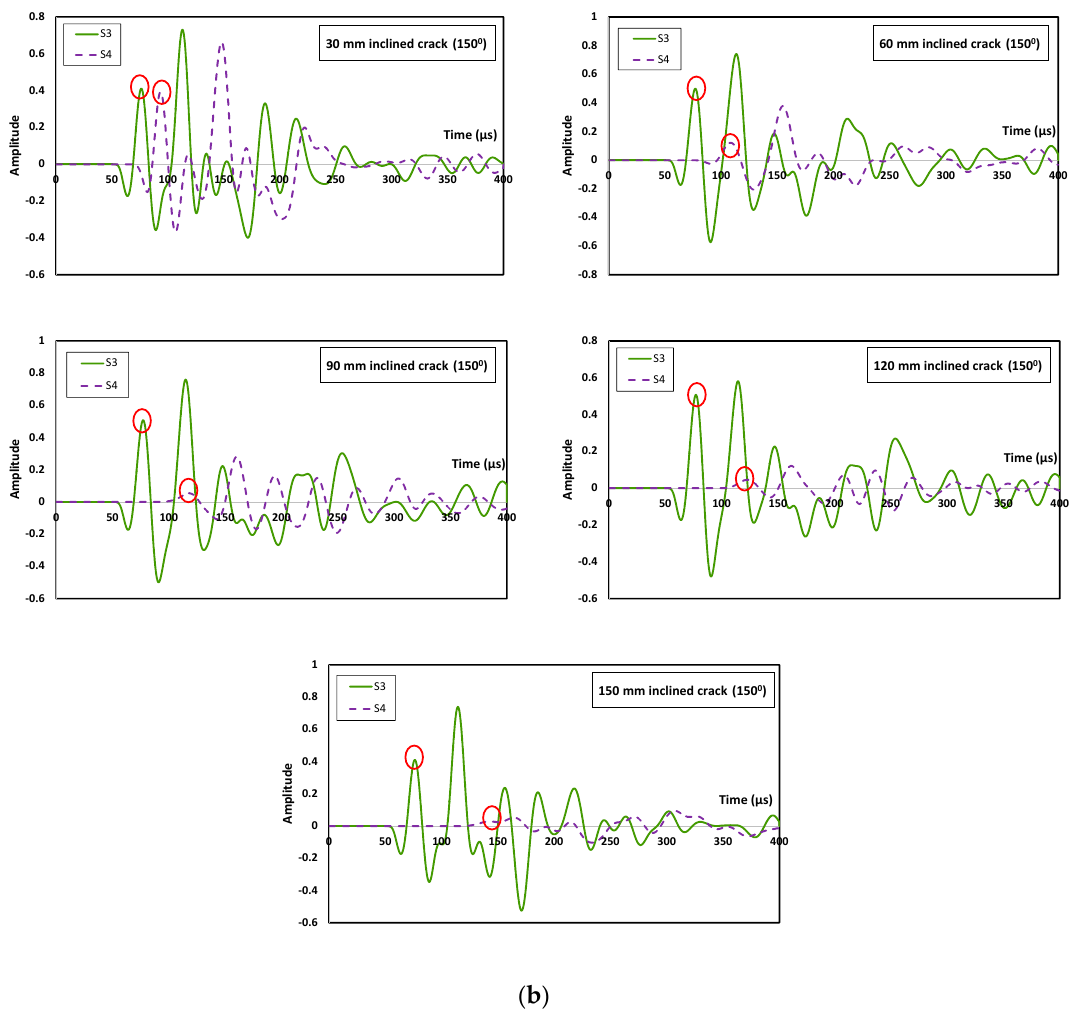
Figure 4. Waveforms collected at the third sensor (S3) and fourth sensor (S4) ( a ) vertical (90°) surface breaking crack and ( b ) inclined (150°) surface breaking crack for 30 kHz excitations.